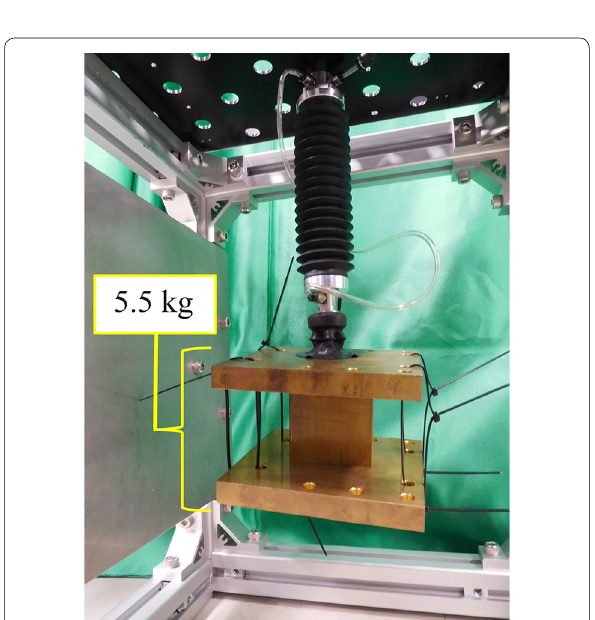
Fig. 19 Evaluation experiment of load-bearing